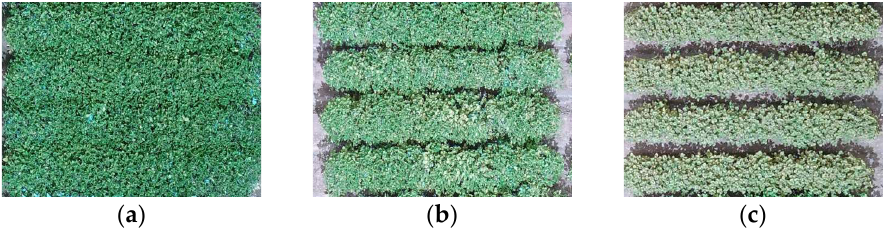
Figure 1. Visual assessment of three tolerance classes of soybeans to off-target dicamba damage, i.e., ( a ) tolerant, ( b ) moderate, and ( c ) susceptible.